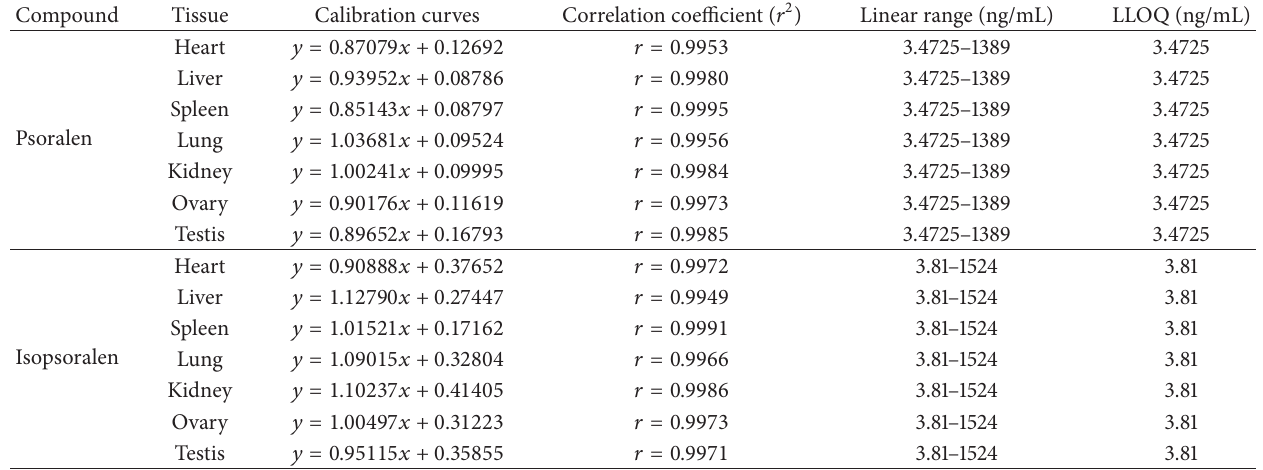
Table 1: Calibration curves, linear range, and LLOQ of psoralen and